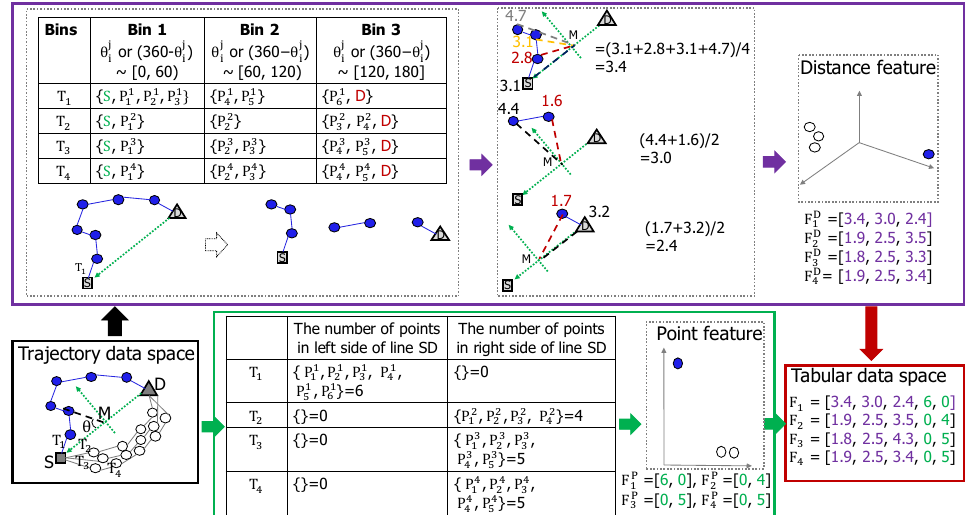
Figure 4. An example of how MiPo converts trajectory data ( Bottom left , black rectangle box) to tabular data ( Bottom right , red rectangle box). MiPo extracts two groups of features from trajectory data, namely the distance ( Top , purple rectangle box) and point features ( Bottom centre , green rectangle box) and merges them as the representation of the original trajectory.